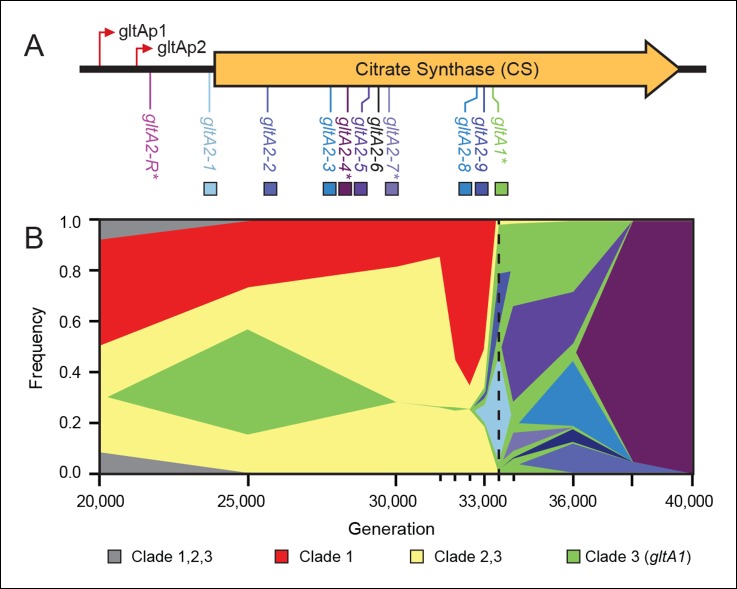
Diversity and dynamics of gltA mutations in the E. coli population that evolved citrate utilization during the Lenski long-term experiment (LTEE).(A) Mutations observed in the citrate synthase protein-coding sequence or upstream intergenic region. The gltA1 mutation evolved first in the LTEE. Many secondary gltA mutations later evolved independently in the LTEE (numbered gltA2 alleles) or in a previous genetic study (gltA2-R). All gltA2 mutations occurred in genetic backgrounds that included gltA1 and the citT and dctA* mutations that confer robust citrate utilization (Quandt et al., 2014). The effects of starred gltA mutations on citrate synthase activity were experimentally characterized in this study. Transcription start sites are labeled gltAp1 and gltAp2 (Wilde and Guest, 1986). See Figure 1—source data 1 for the DNA and protein sequence changes caused by each gltA mutation. (B) Muller plot of evolved allele frequencies over time constructed by using metagenomic DNA sequencing to profile archived samples of the LTEE population. Shaded regions correspond to the frequencies of genetically diverged subpopulations distinguished by different evolved alleles. When a colored sector arises within another region, it is a descendant of that genotype with at least this one new mutation and all of the mutations present in the earlier genotype because these populations are strictly asexual. Clades 1–3 correspond to a phylogenetic tree previously constructed by sequencing the genomes of clonal isolates (Blount et al., 2012), which also constrains the order of certain mutations (e.g., gltA1 < citT < dctA* < any gltA2). Each of the gltA2 alleles (shaded as in panel A) evolved independently and defines a separate evolved genotype and all of its descendants. Sequencing was performed on population samples from the times indicated with tick marks, and allele dynamics are shown as linearly interpolated between these points. The cell density of the entire LTEE population increased just prior to the dashed line at 33,500 generations (Blount et al., 2008) when refined Clade 3 Cit++ genotypes containing the citT and dctA* mutations evolved (Blount et al., 2012). Figure 1—source data 2 shows the mutations used to track the different clades.DOI:
http://dx.doi.org/10.7554/eLife.09696.00310.7554/eLife.09696.004Figure 1—source data 1.Details for all gltA alleles in this study.DOI:
http://dx.doi.org/10.7554/eLife.09696.00410.7554/eLife.09696.005Figure 1—source data 2.Mutations used to track clade dynamics in the LTEE.